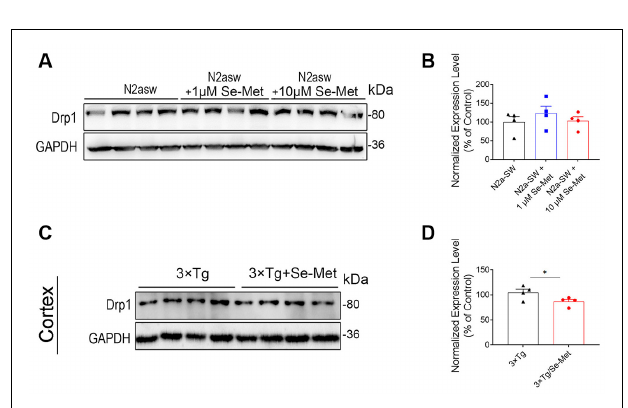
FIGURE 4 | Se-Met inhibited mitochondrial fission in the cortices of 8-month-old AD mice. (A–D) The expression levels of Drp1 in N2a-SW cells (A) and in the cortices of AD mice (C) were detected by western blot analysis. (B,D) Quantitative analysis of the expression level of Drp1 ( ∗ p < 0.05, n = 4).